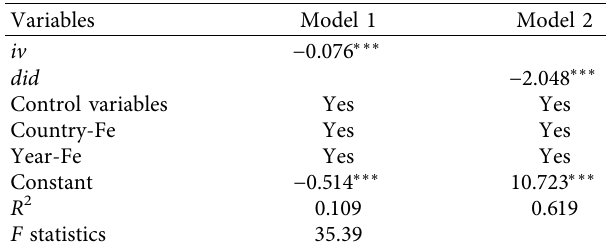
Table 6: Instrumental variable test